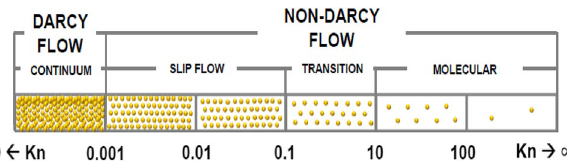
Fig. 1 Flow regimes as per Knudsen in the microscopic porous medium